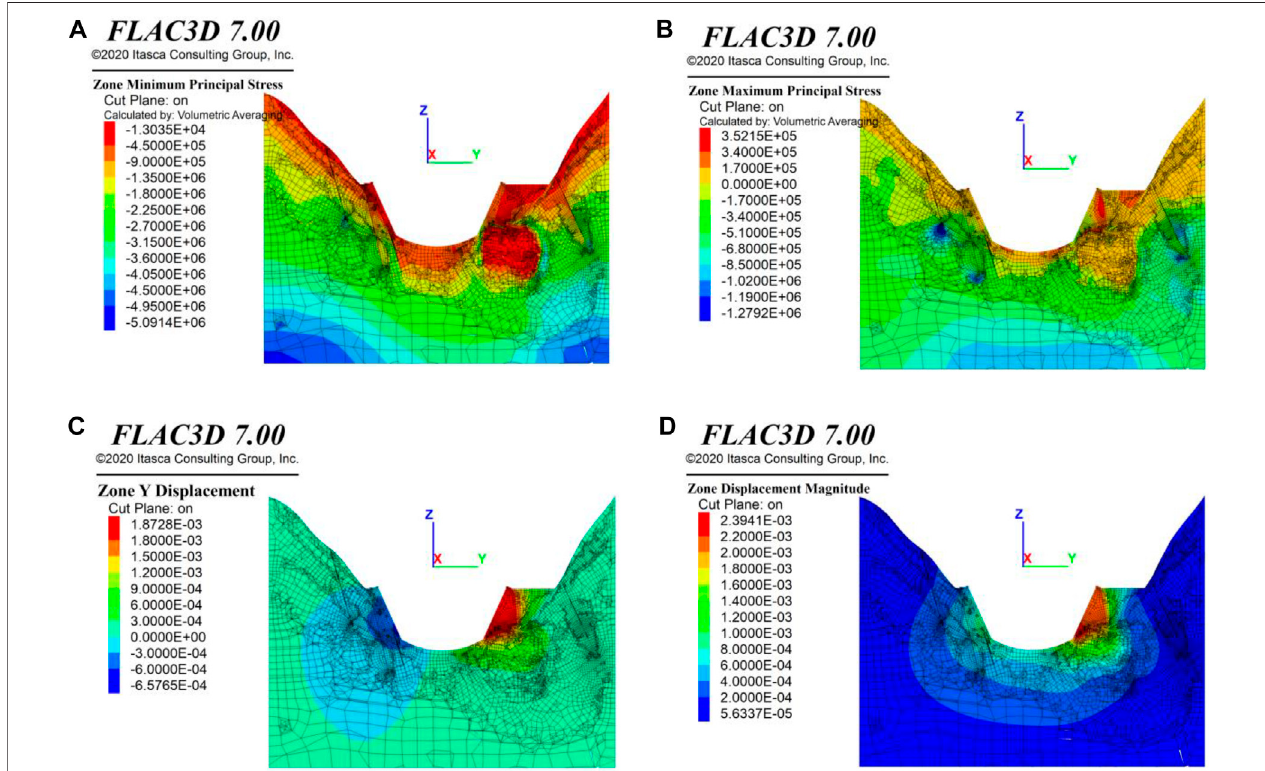
FIGURE 4 | Numerical modelling results at the Pro fi le (Dam 0 + 145.25 m) for the working condition of the frequent fl ood: (A) Major principal stress, (B) Minor principal stress, (C) Displacement transverse the river, (D) Resultant displacement.